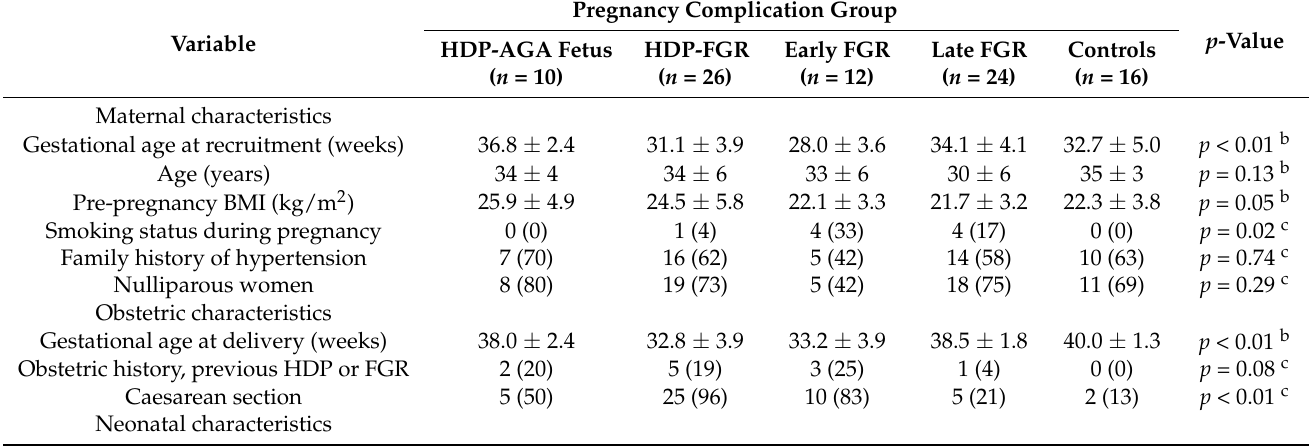
Table 1. Maternal, obstetric, and neonatal characteristics a according to pregnancy complication groups and